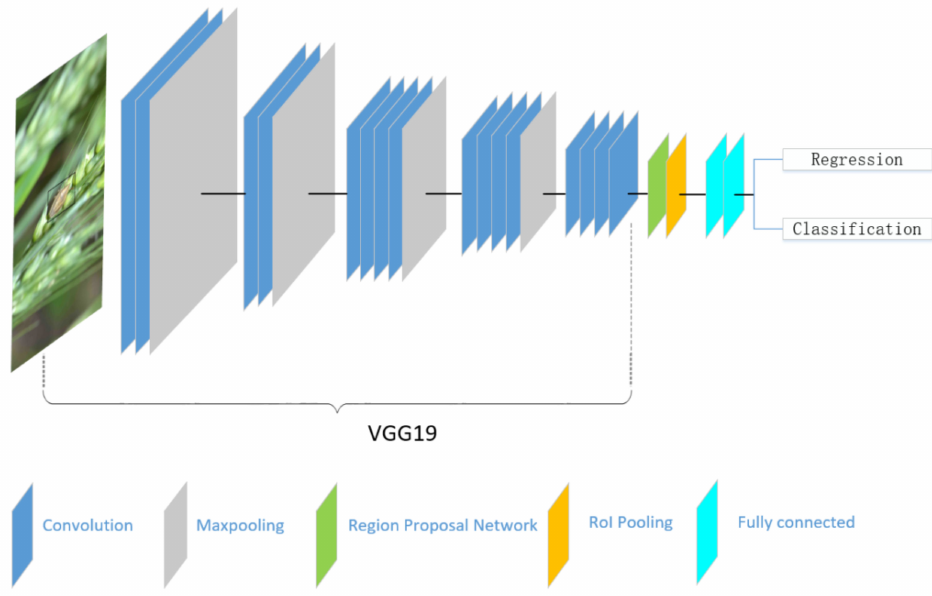
Figure 2. The schematic structure of the proposed detection model based on